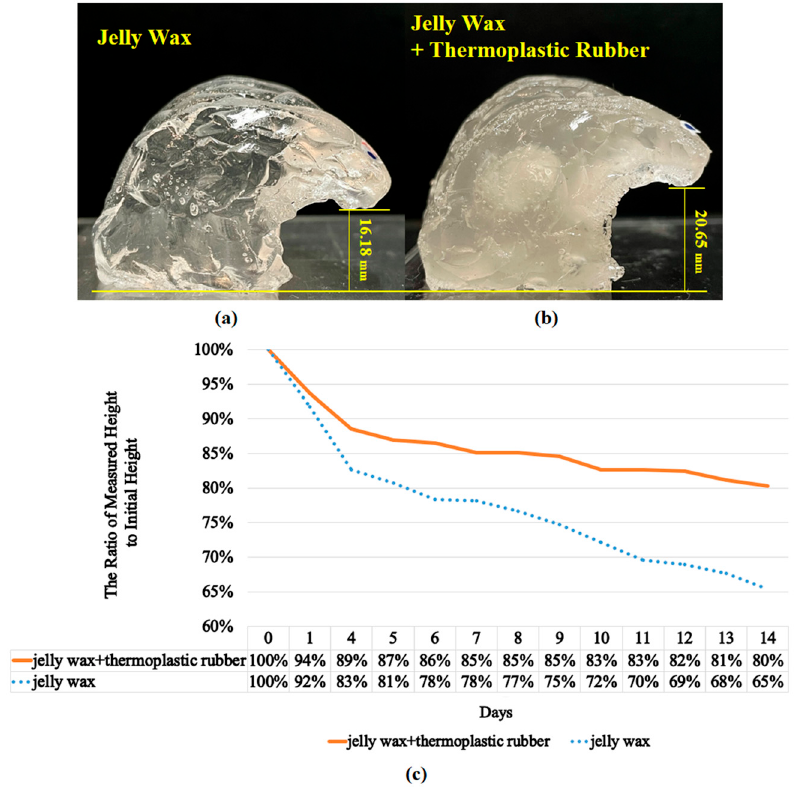
Figure 5. ( a ) Measured height of brain lobe made of jelly wax only after 14 days; ( b ) measured height of brain lobe made of jelly wax and thermoplastic rubber after 14 days; ( c ) comparison chart showing the measured height in terms of days for both cases.